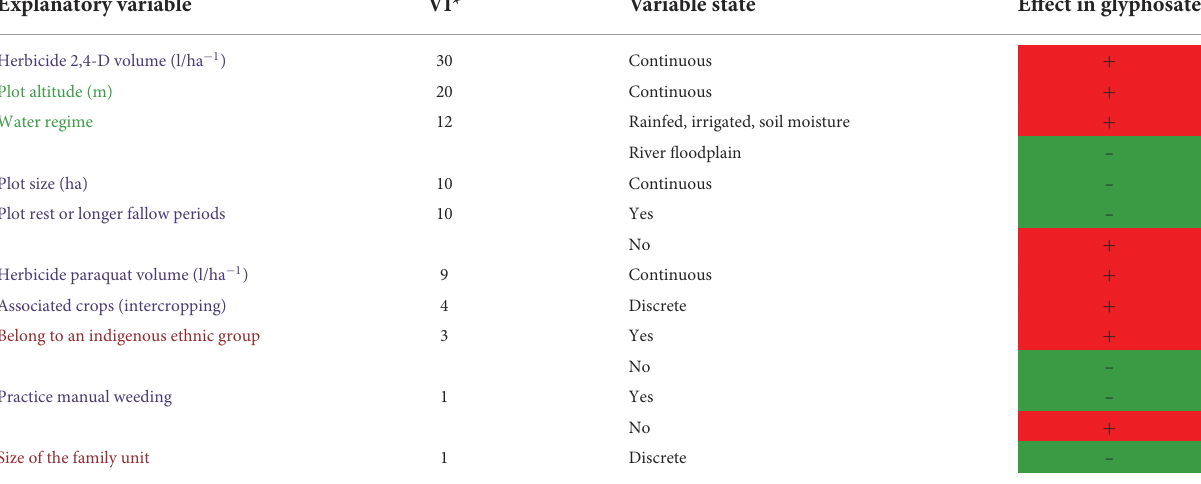
TABLE 3 The most important variables in the construction of the regression tree and its effect on the increase or decrease in glyphosate